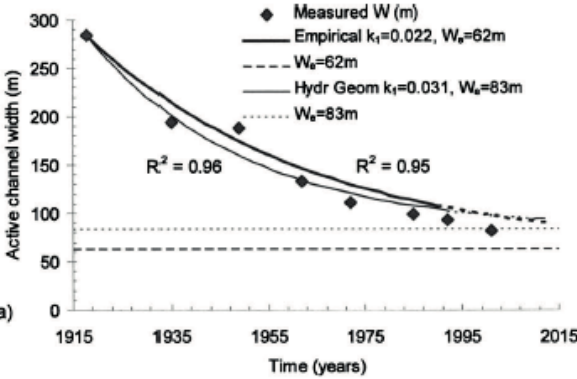
Fig. 5 Gradual changes in channel width below Cochiti dam from Richard et al .